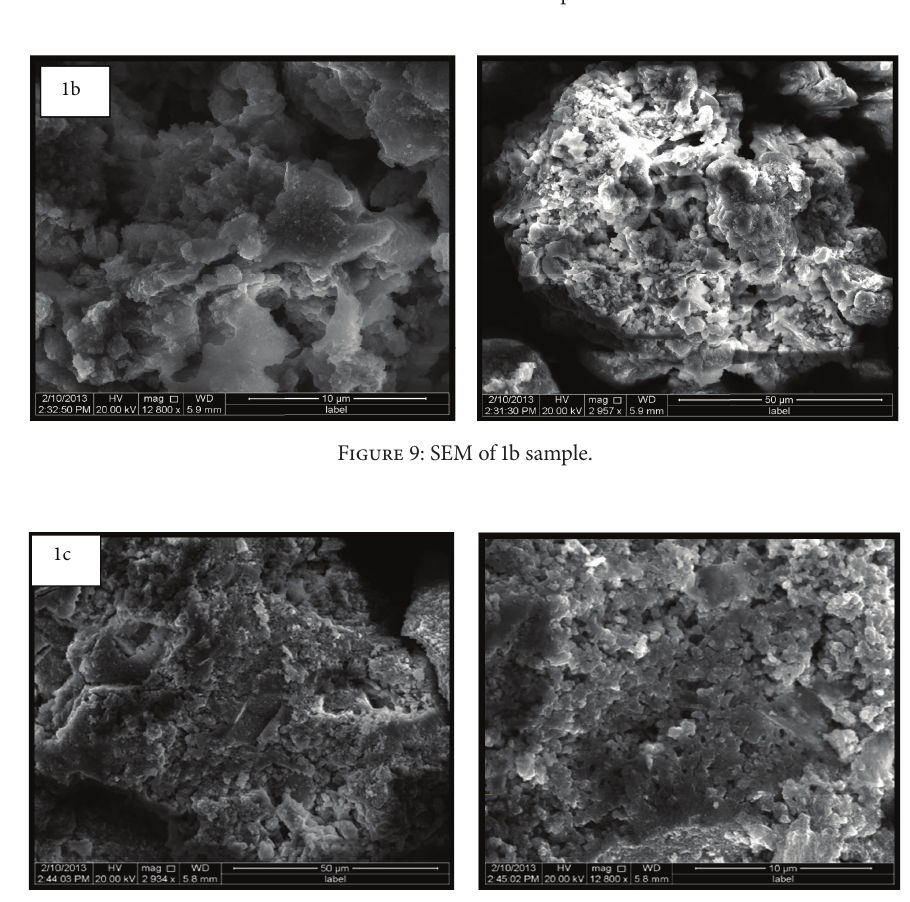
Figure 8: SEM of 1a sample.